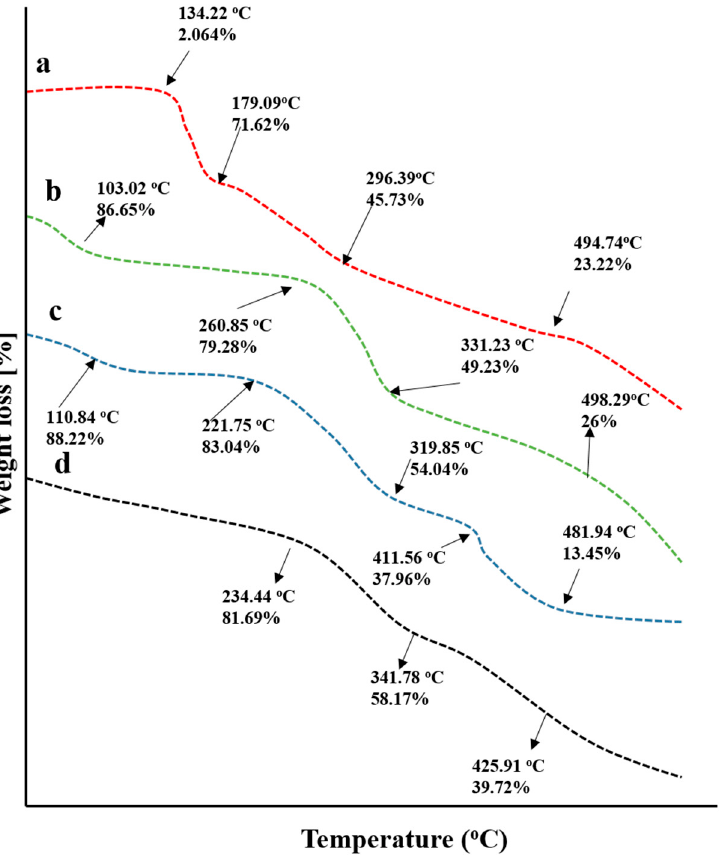
Figure 7. TGA thermograms of ( a ) capecitabine, ( b ) chitosan, ( c ) fenugreek seed extract, and ( d ) drug loaded hydrogels.